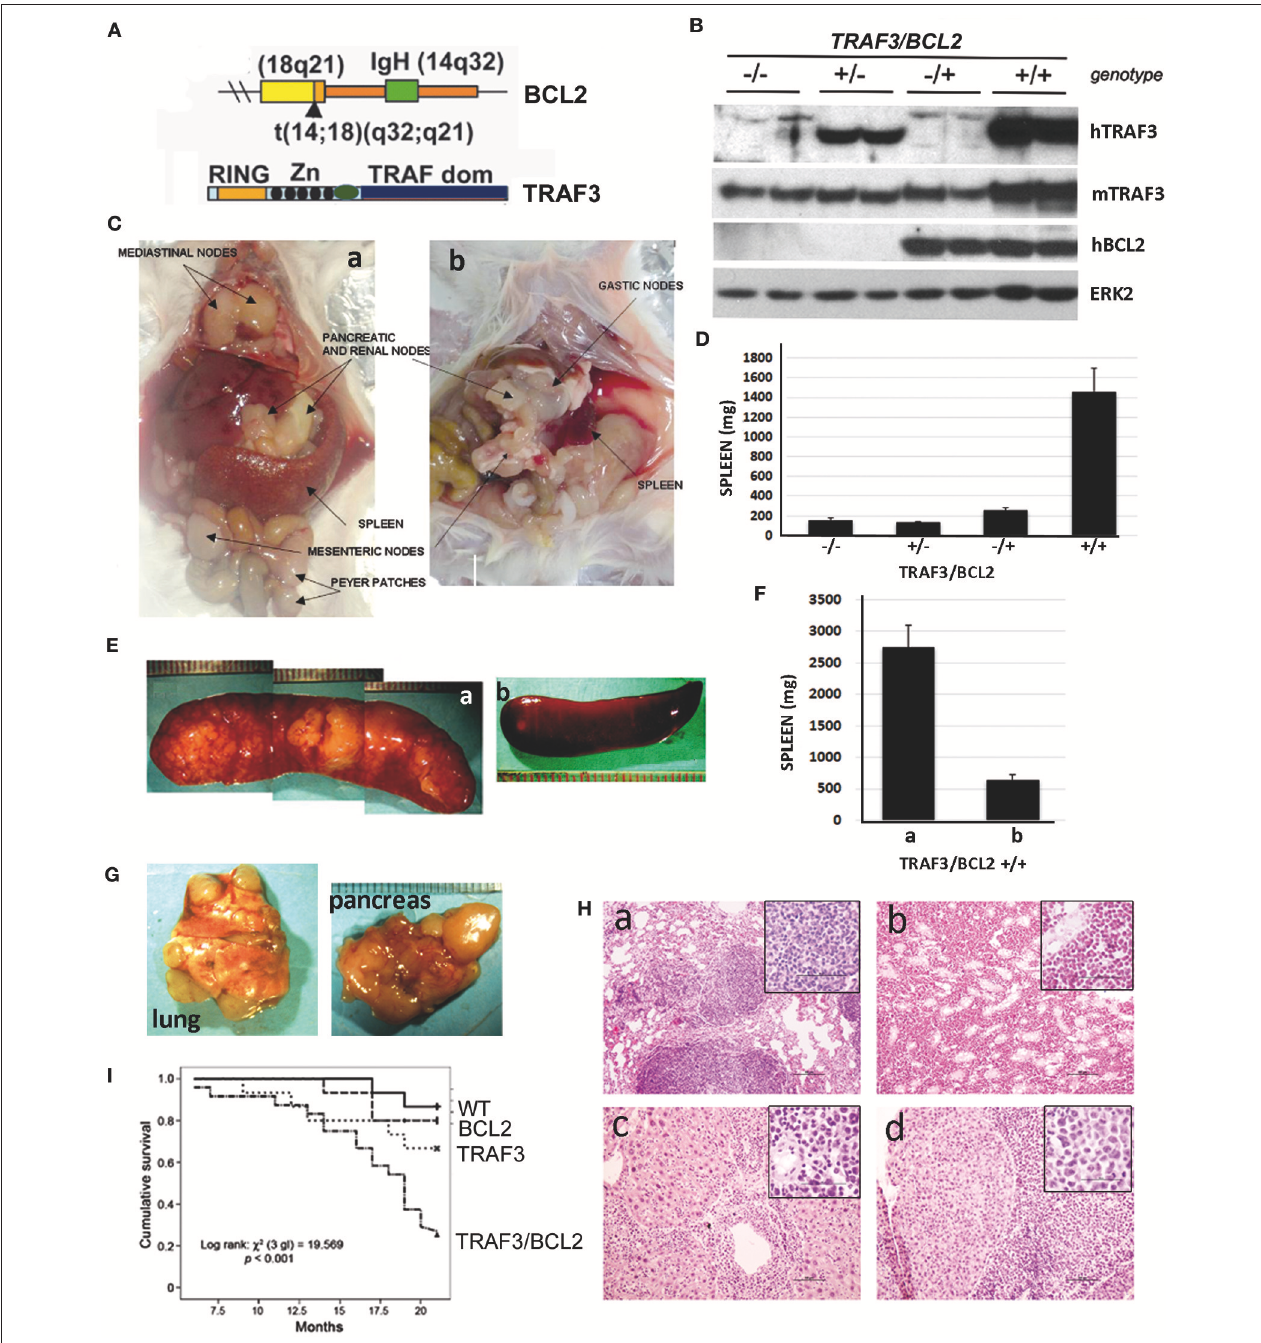
FIGURE 1 | TRAF3/BCL2 double-tg mice develop severe lymphoid dysplasias and have a reduced lifespan. (A) Schematic representation of the expressed transgenes. BCL2 gene mimics the t(14;18)(q32;q21) translocation involving BCL2 and IgH found in human FLs resulting in BCL2 overexpression. TRAF3 is under the control of the IgH promoter and the µ enhancer. (B) Representative examples of the TRAF3 and BCL2 expression in spleen extracts from mice with different TRAF3/BCL2 genotypes. Expression of ERK2 is used as loading control. (C) Representative examples of TRAF3/BCL2 double-tg mice with lymphoid dyscrasias. Mice usually develop two types of lymphadenopathies, group 1 characterized by massive splenomegaly and disseminated lymphadenopathy (a) and group 2 with moderate splenomegaly and disseminated lymphadenopathy (b) . (D) Weight of the spleens of mouse littermates with the different TRAF3/BCL2 genotypes (–/–, n = 7; + /–, n = 10; –/ + , n = 10; + / + , n = 32). Mice were euthanized when + / + mice developed lymphoid dyscrasias. Data represent mean ± SEM. (E) Representative examples of the enlarged spleens developed by diseased TRAF3/BCL2 -double-tg mice. The pictures illustrate the differences in aspect and morphology of group 1 (a) and group 2 (b) spleens. (F) Weight of the spleens of group 1 [ (a) , n = 13] and group 2 [ (b) , n = 19]. Mice were euthanized when + / + mice developed lymphoid